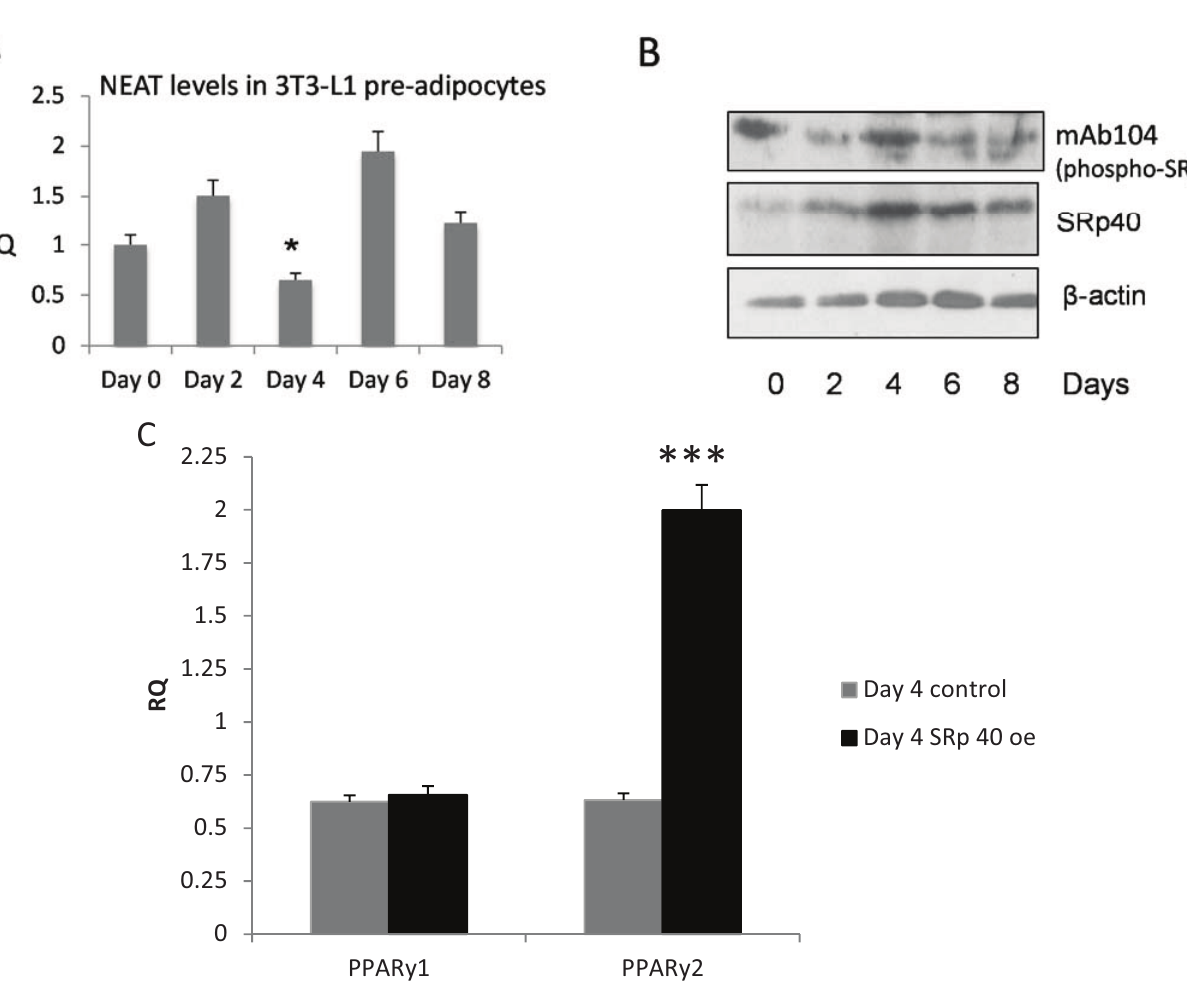
Figure 2. Regulation of NEAT1 and SRp40 proteins during adipogenesis. A. Levels of